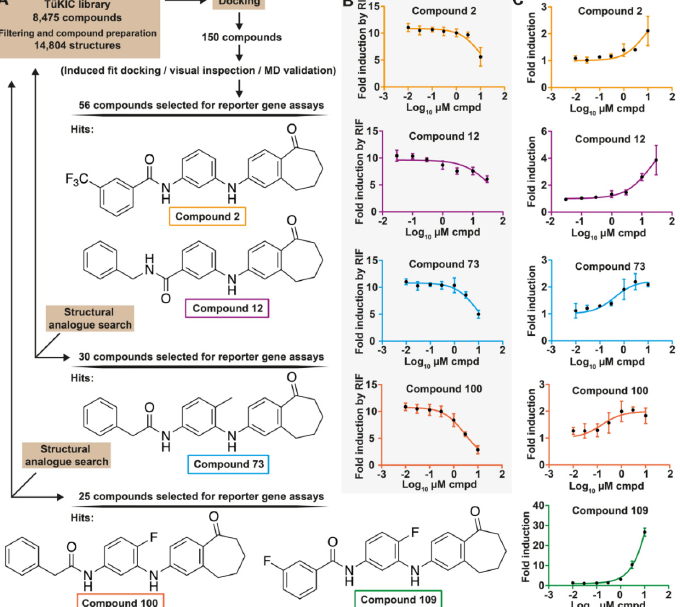
Figure 1. Identification of novel putative PXR ligands from the TüKIC library. ( A ) Workflow of the in silico screening and structures of the identified candidate ligands. ( B ) Concentration–response curves of the novel inhibitors for antagonism of PXR activity. ( C ) Concentration–response curves of the same compounds and 109 for PXR activation. H-P cells were transfected with CYP3A4 promoter reporter and cotreated with 10 µM rifampicin (RIF) and increasing concentrations of the indicated compounds ( B ) or treated with increasing concentrations of the novel compounds only ( C ) for 24 h. Data are expressed as mean ± SD fold induction with respect to the DMSO-treated cells from three independent experiments. IC 50 and EC 50 values calculated with nonlinear regression using formula with 3 parameters (constraint bottom =1) using GraphPadPrism.